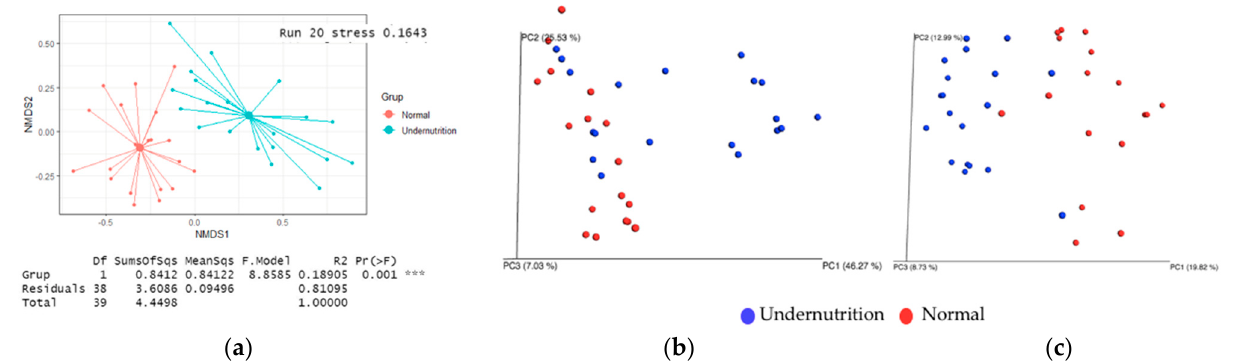
Figure 4. Beta diversity of gut microbiota composition. ( a ) Bray–Curtis; ( b ) weighted UniFrac; ( c ) Unweighted UniFrac.